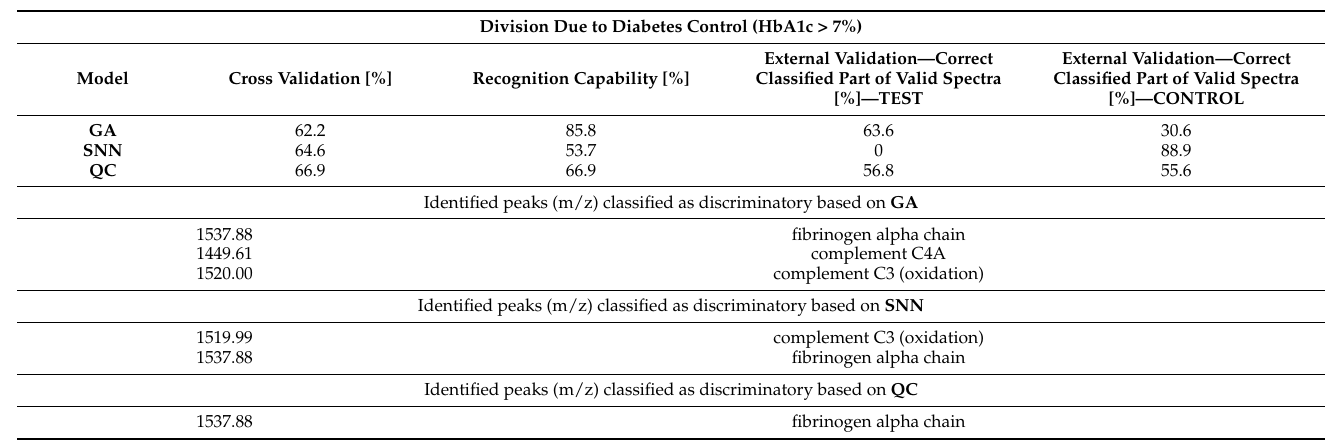
Table 5. Division due to diabetic control (HbA1c > 7%).